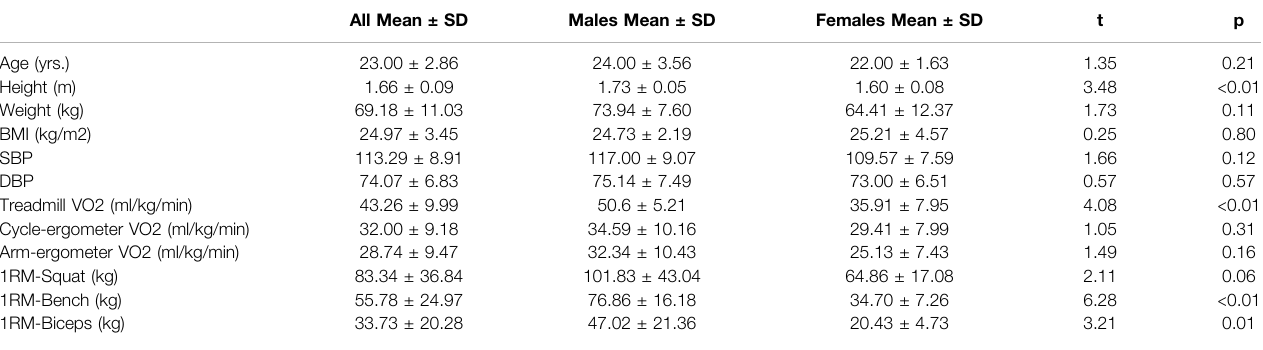
TABLE 1 | Demographic and descriptive data of the participants.